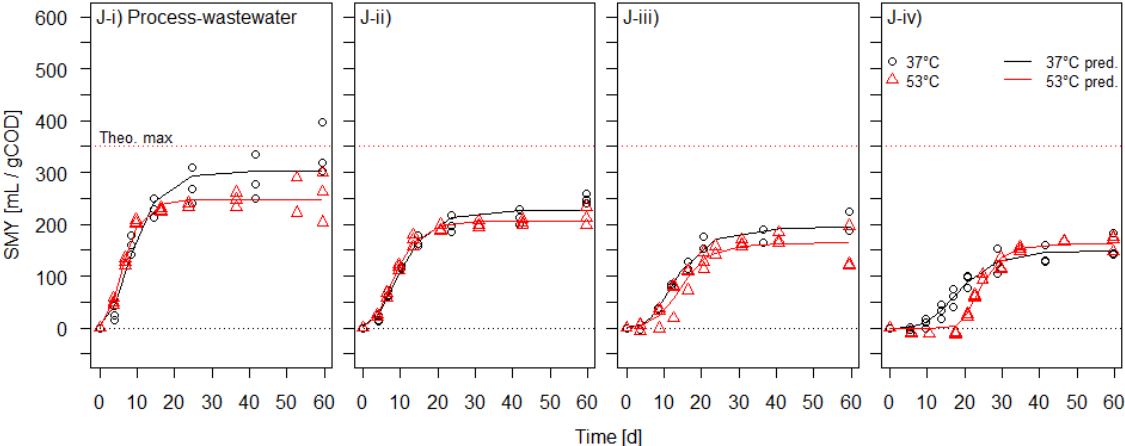
Figure 6. Measured specific methane yields for the process-wastewater from its per batch-test added amounts of ( i ) 0.1 gCOD, ( ii ) 0.2 gCOD, ( iii ) 0.3 gCOD, and ( iv ) 0.4 gCOD under mesophilic and thermophilic conditions, along with the fitted modified Gompertz functions (n = 3 for all the test concentrations at 37 °C and 53 °C except n = 2 for 0.3 gCOD wastewater at 37 °C).